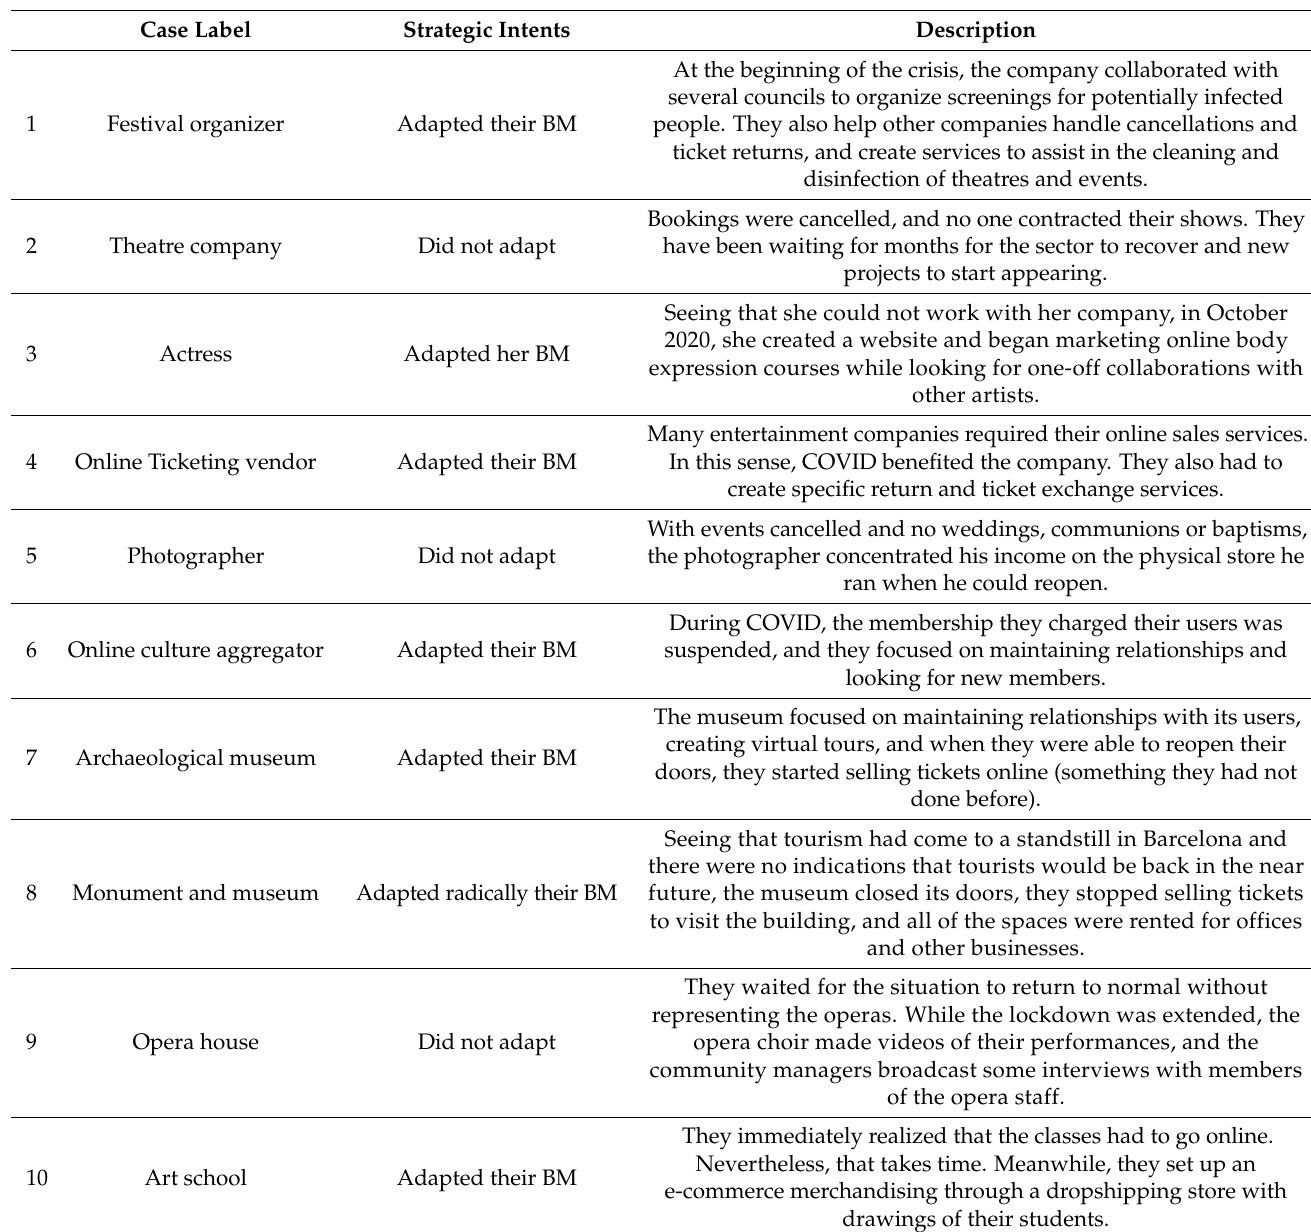
Table 2. Strategic response to the